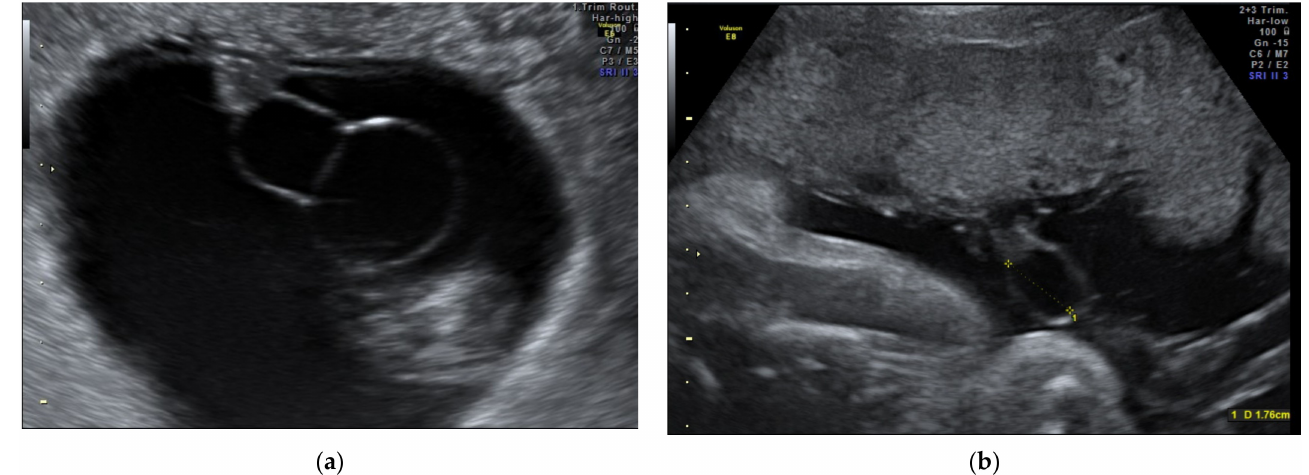
Figure 12. Cyst observed in the 2D ultrasound ( a , b